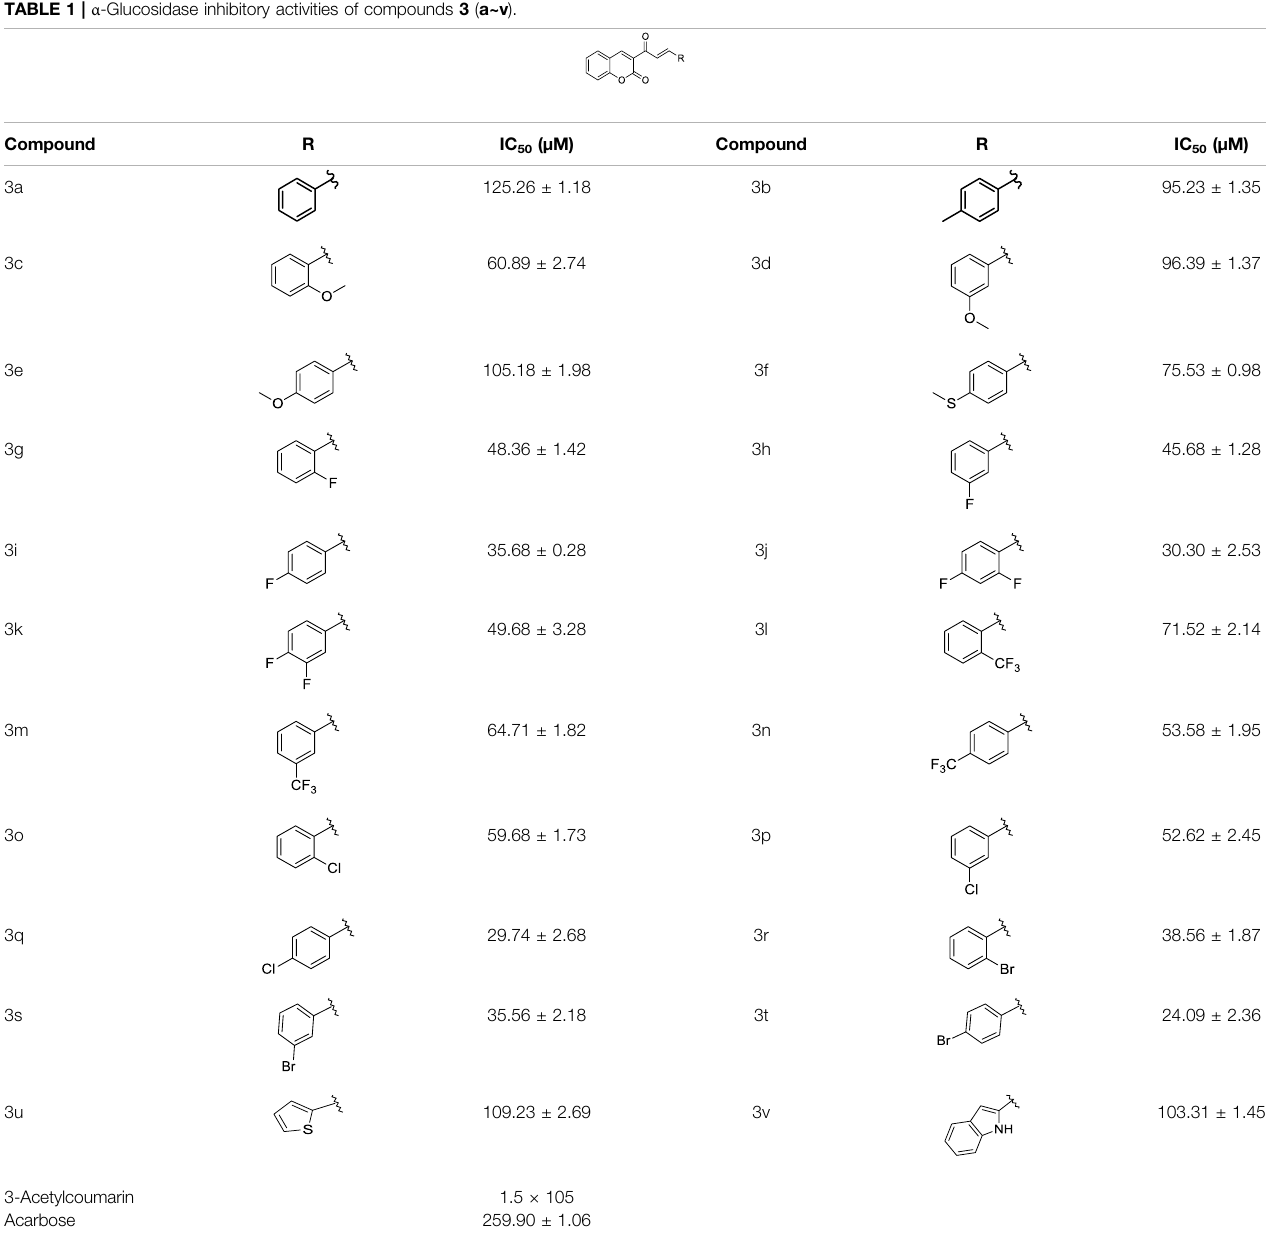
TABLE 1 | α -Glucosidase inhibitory activities of compounds 3 ( a~v ).